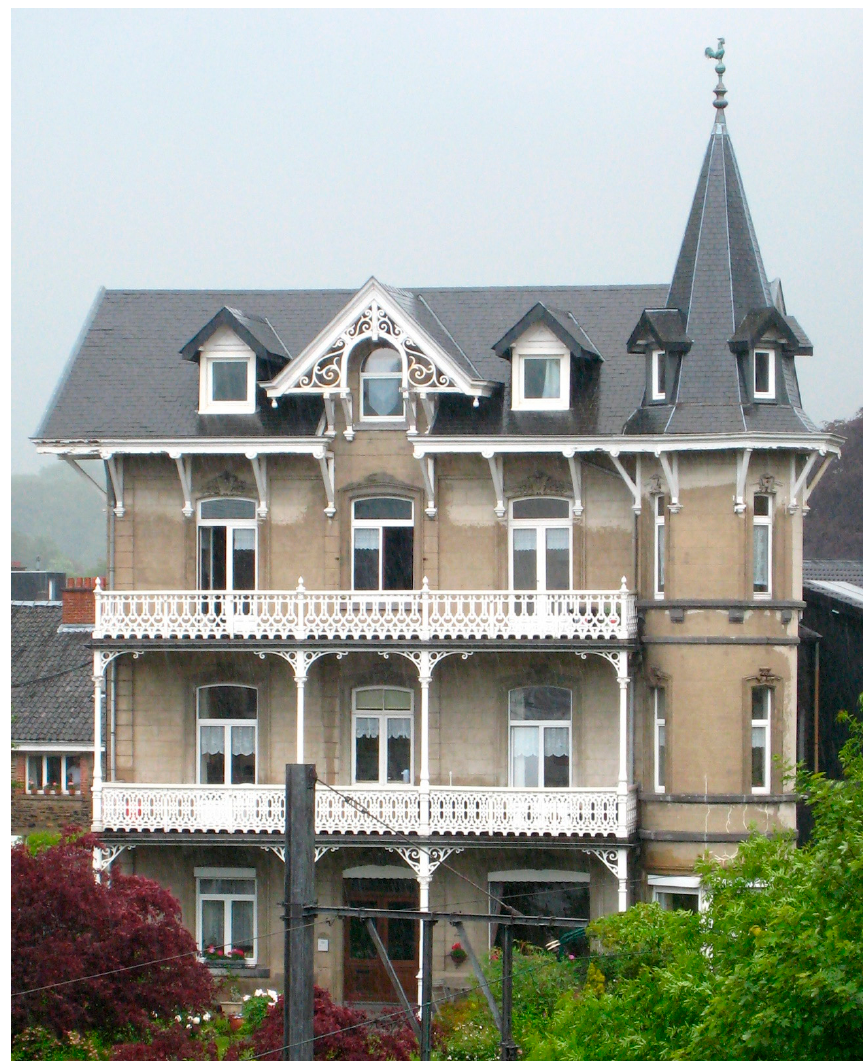
Figure 3. The characteristic features of traditional ‘greatcoat’ architecture, such as wide eaves and hood mouldings, may appear decorative, but their primary purpose is entirely practical: to stop rainwater penetrating weak points of the wall. ©Clive Murgatroyd.